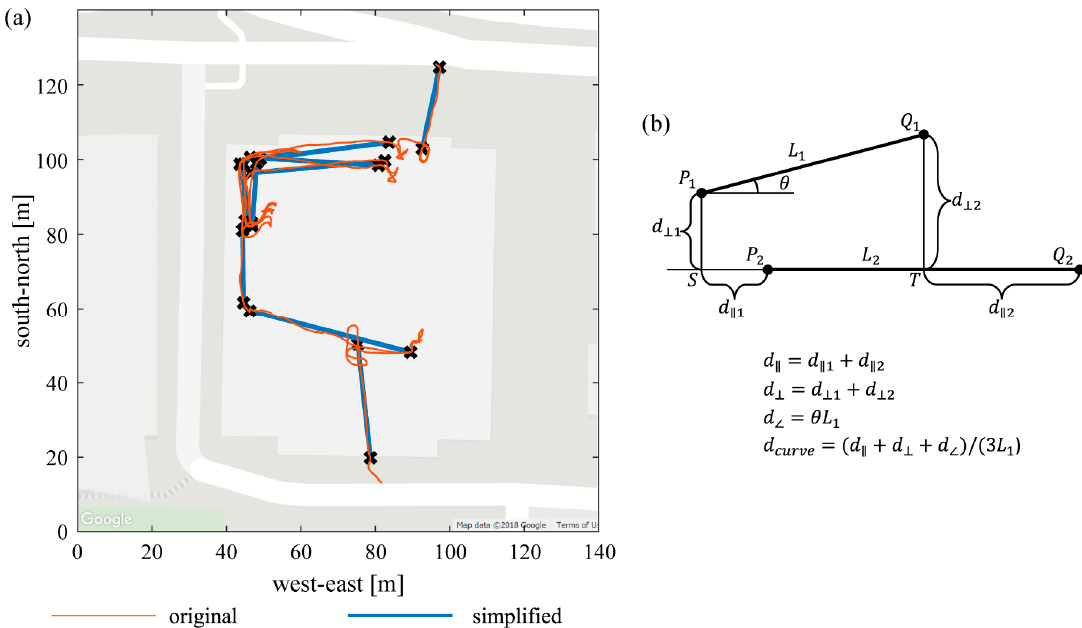
Figure 3. Curve simplification and distance. ( a ) Simplification result of a sample path: the original trajectory before discretization is indicated by the thin red curve, the straight segments separated from the original curve are indicated by bold blue lines and black markers. Typical straight walking trajectories in hallways are singled out after curve simplifications. ( b ) Definition of “curve distance”, for assessing spatial separation of two paths, lengths L1 (shorter) and L2 (longer). Curve distance is a composite of: Parallel distance (distance between two segments’ starting points along the longer path); perpendicular distance (distance of the start and end of L1 from the line of L2); and angular distance (angle between path directions, including progress direction, times L1).